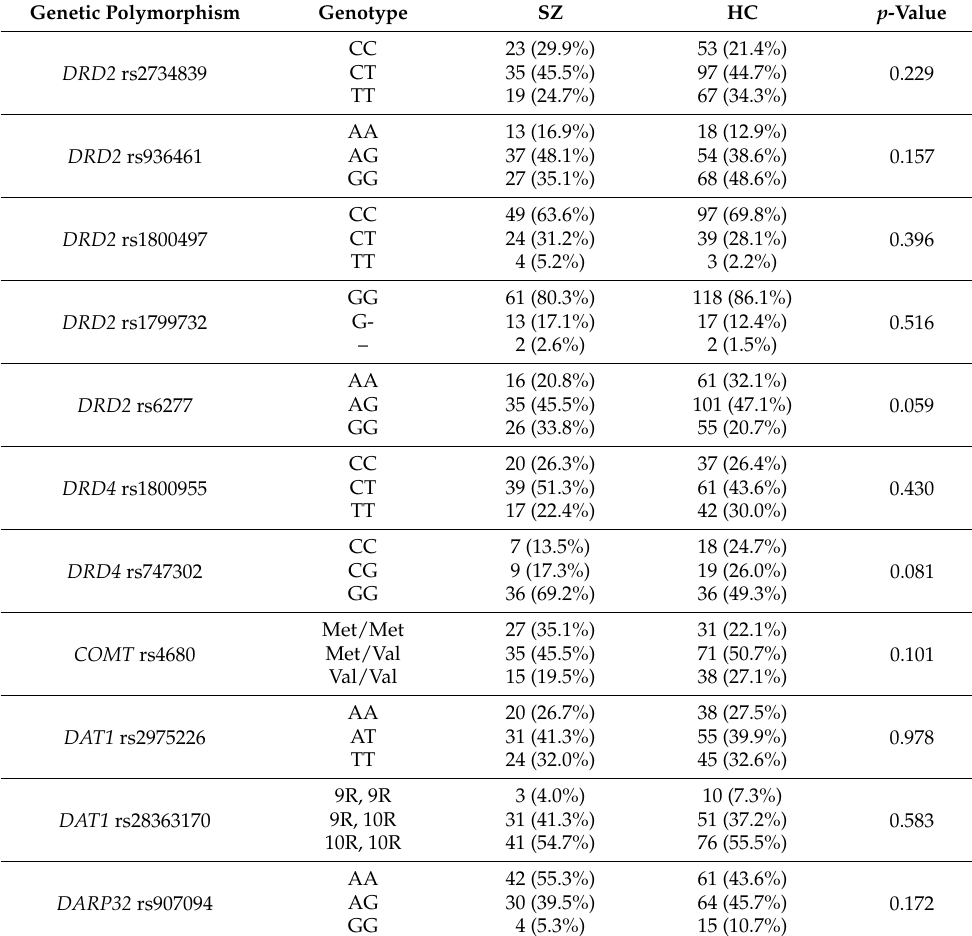
Table A1. Distribution of genotypes in SZ patients and HC participants.